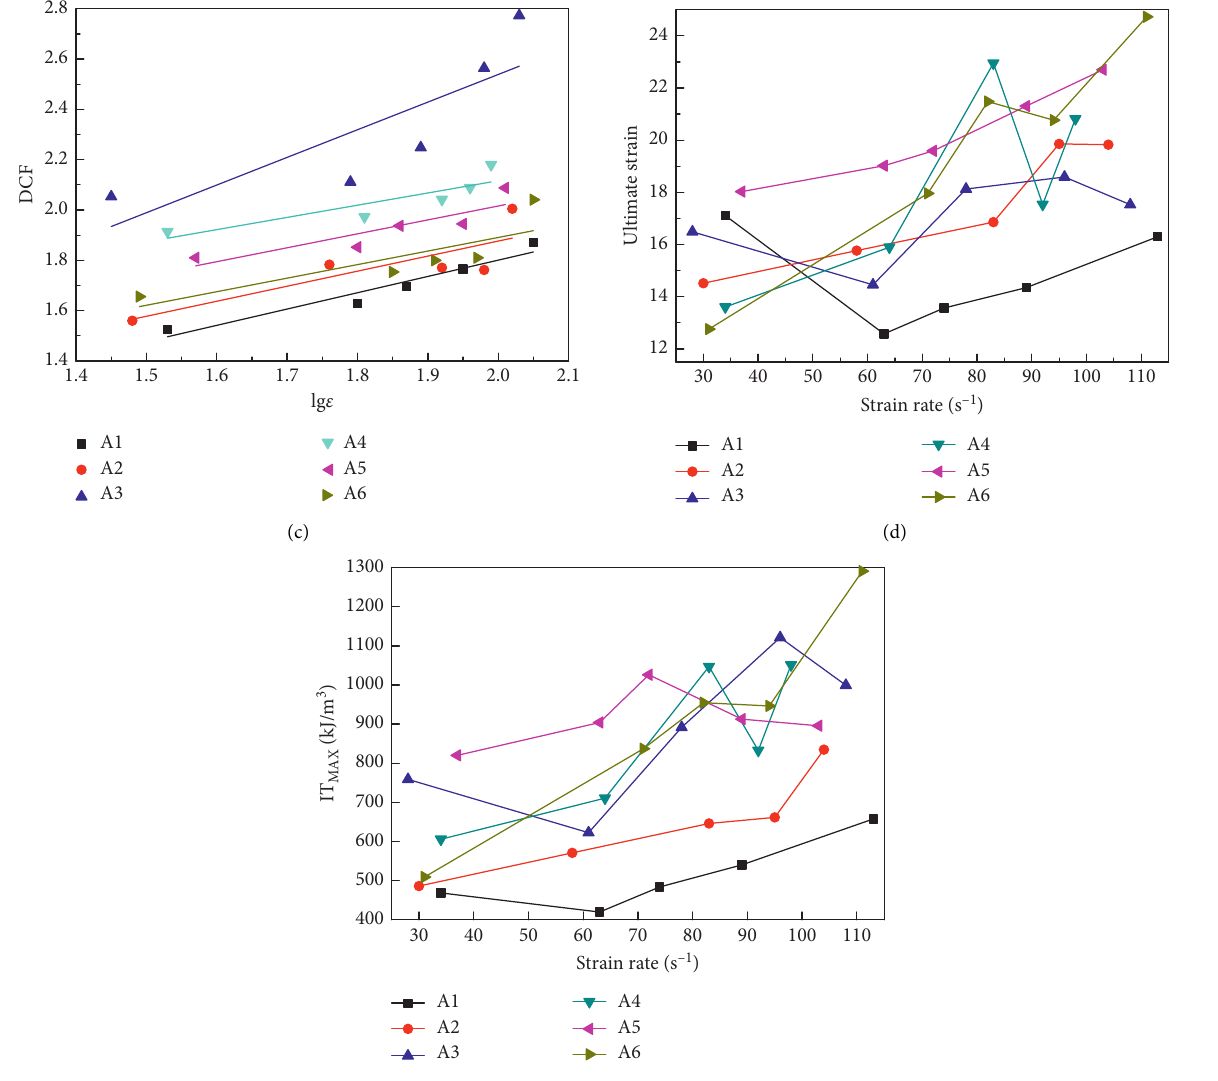
Figure 6: Strain rate effect on characteristic dynamic parameters of concrete: (a) on the peak stress, (b) on the increase ratio of peak stress, (c) on the DCF, (d) on the ultimate strain, and (e) on impact toughness IT MAX .